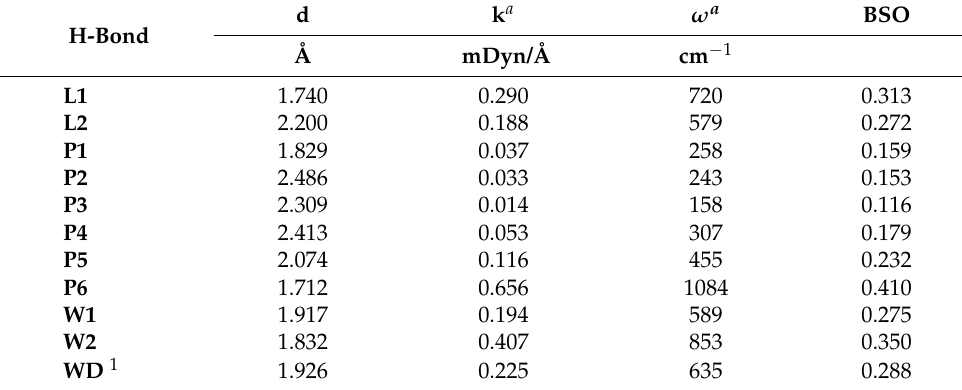
Table 5. The local mode parameters of the hydrogen bonds between Kaempferol and NS5 from the QM/MM calculations, the ω B97X-D/6-31G(d,p)/AMBER level of theory for the calculation in the protein, and the ω B97X-D/6-31G(d,p) level of theory in the gas